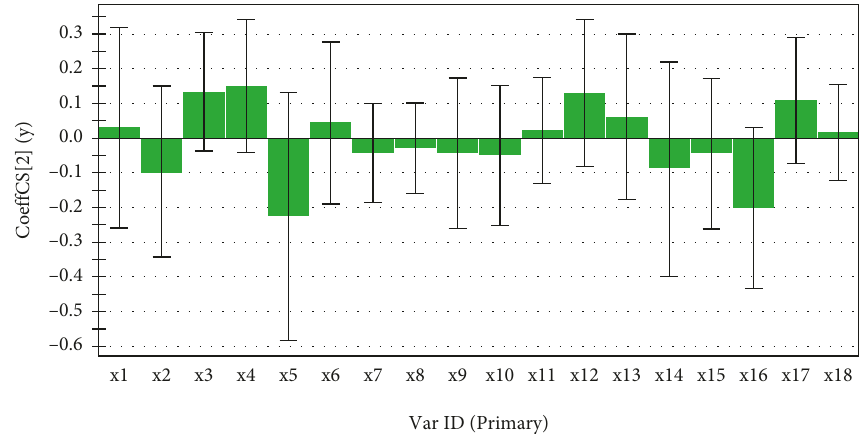
Figure 6: Partial regression coefficient plot of common peaks and anti-inflammatory efficacy values.